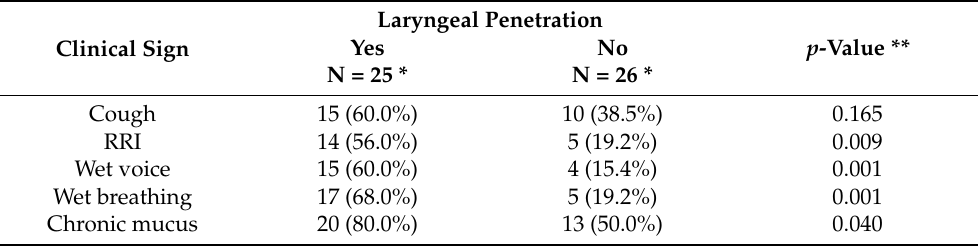
Table 1. Relationships between clinical signs and occurrence of laryngeal penetration in videofluoro- scopic swallowing